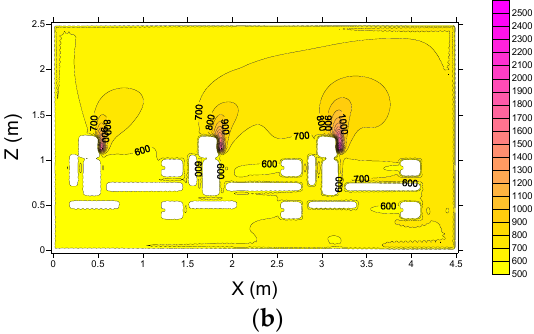
Figure 13. CO 2 concentration field in the virtual classroom with 12 occupants in the plans ( a ) X = 1.791 m and ( b ) Y = 0.4423 m, with an inlet air temperature of 20 °C.